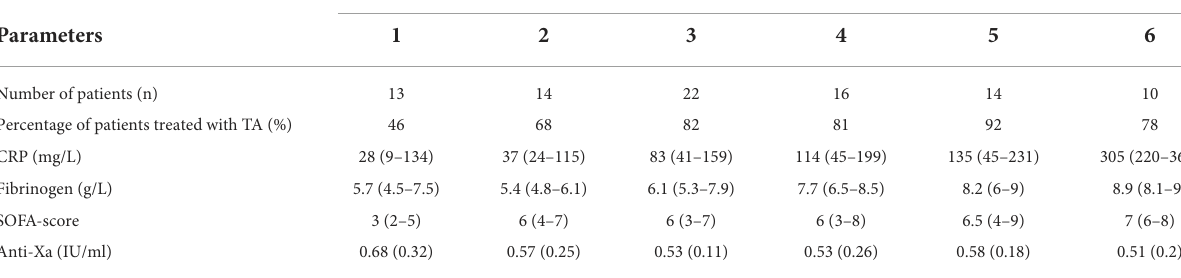
TABLE 2 Number of COVID-19 patients, the incidence of therapeutic anticoagulation, routine laboratory measurements, SOFA-score, and anti-Xa levels per week starting from intubation.